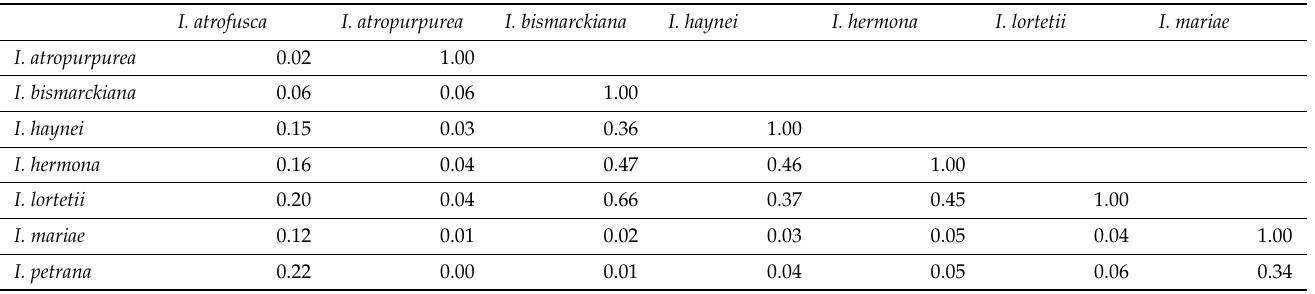
Table 1. D values between the eight Iris species. The values are calculated for the species in the rows, with respect to the species in the columns. Shades denote the extent of the eco-geographical overlap, i.e., black for high overlap and white for complete isolation.